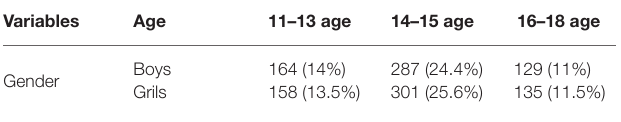
TABLE 1 | Sample distribution according to age and